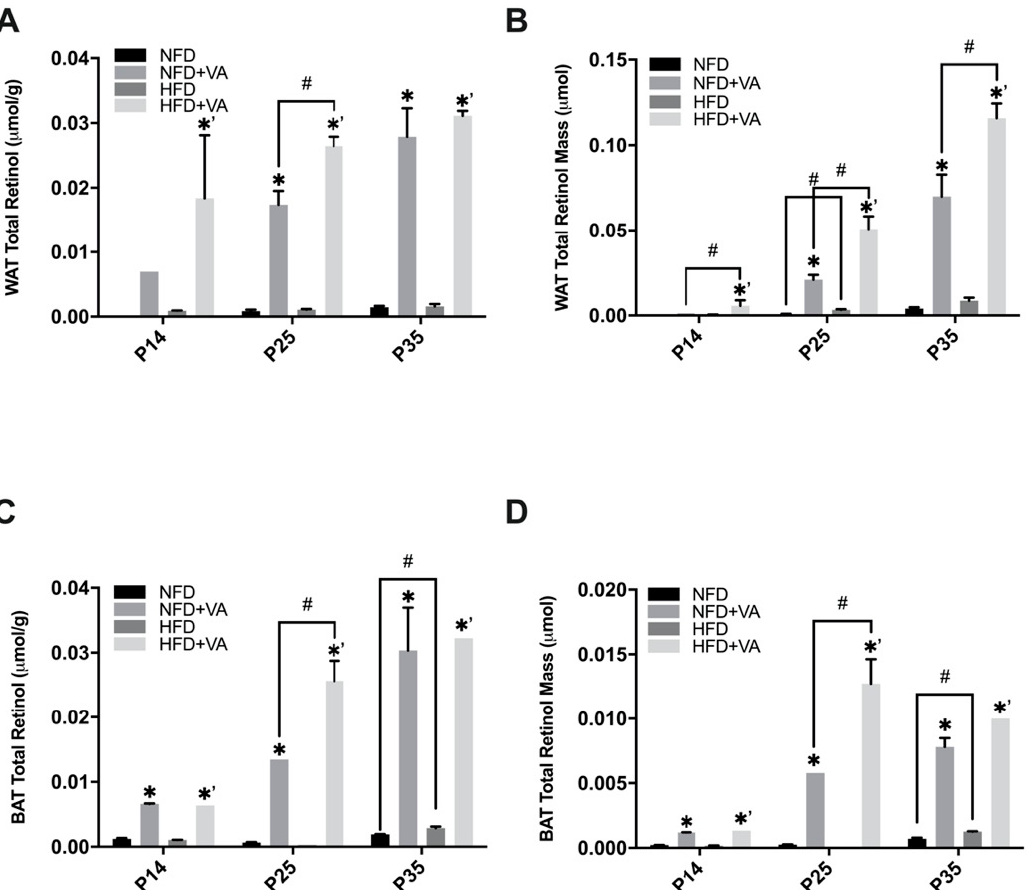
Figure 3. Total retinol concentration and mass of white adipose tissue ( A , B ) and brown adipose tissue ( C,D ). Bars show mean ± SEM, n = 4 or 3 per group. Significant difference, p < 0.05, between NFD and NFD+VA was indicated by *, between HFD and HFD+VA by * ’ , and between NFD and HFD or between NFD+VA and HFD+VA by #. P14, postnatal day 14; P25, postnatal day 25; P35, postnatal day 35; NFD, normal fat diet; HFD, high fat diet; VA, vitamin A. Note: At P14, white adipose tissue samples in the NFD group were not adequate for analysis, and therefore data are missing.